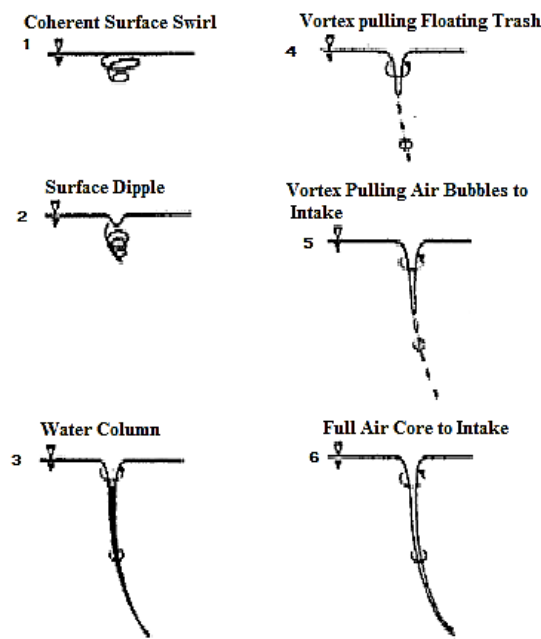
Fig .1 Vortex type classification (Hecker,